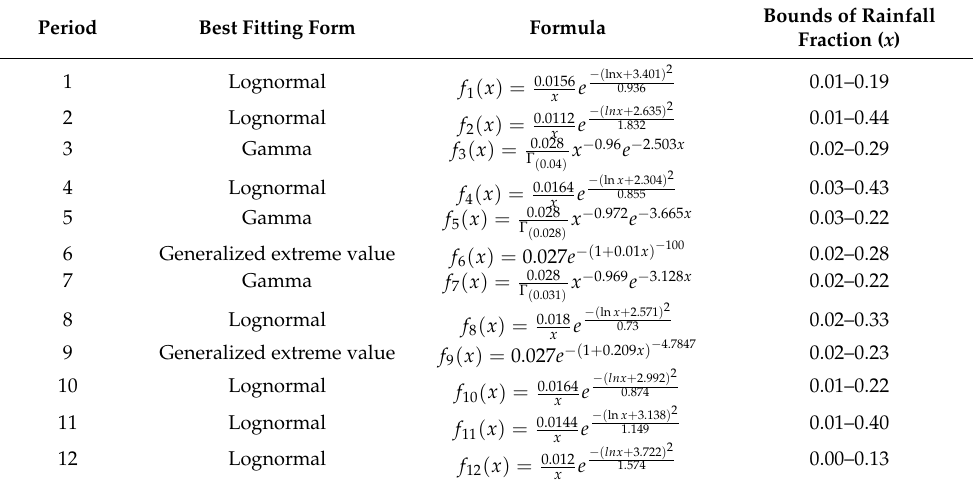
Table 2. Best-fitting probability distribution functions for 12